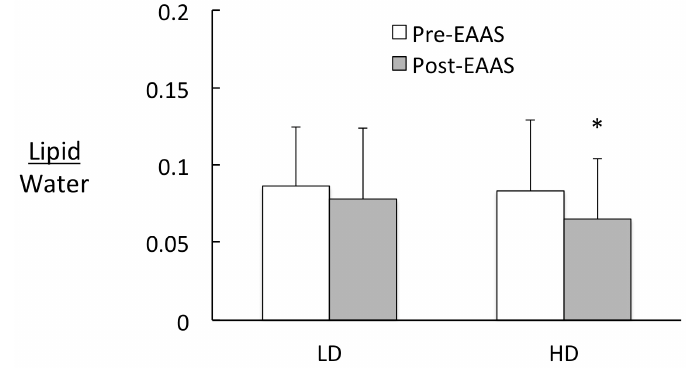
Figure 3. Intrahepatic lipid in low dose (LD) and high dose (HD) pre- and post-essential amino acid supplement (EAAS). * Represents a significant difference between pre- and post-EAAS ( p = 0.02). Blood parameters. Total cholesterol, LDL-cholesterol, VLDL-cholesterol, HDL-cholesterol, and triglycerides were all within normal limits and did not differ between groups and did not change with EAAS (Table 2). Except for blood Peth, all other blood parameters were also within normal limits and were not altered by EAAS, indicating the lack of any undesirable effects of EAAS on lipid, liver